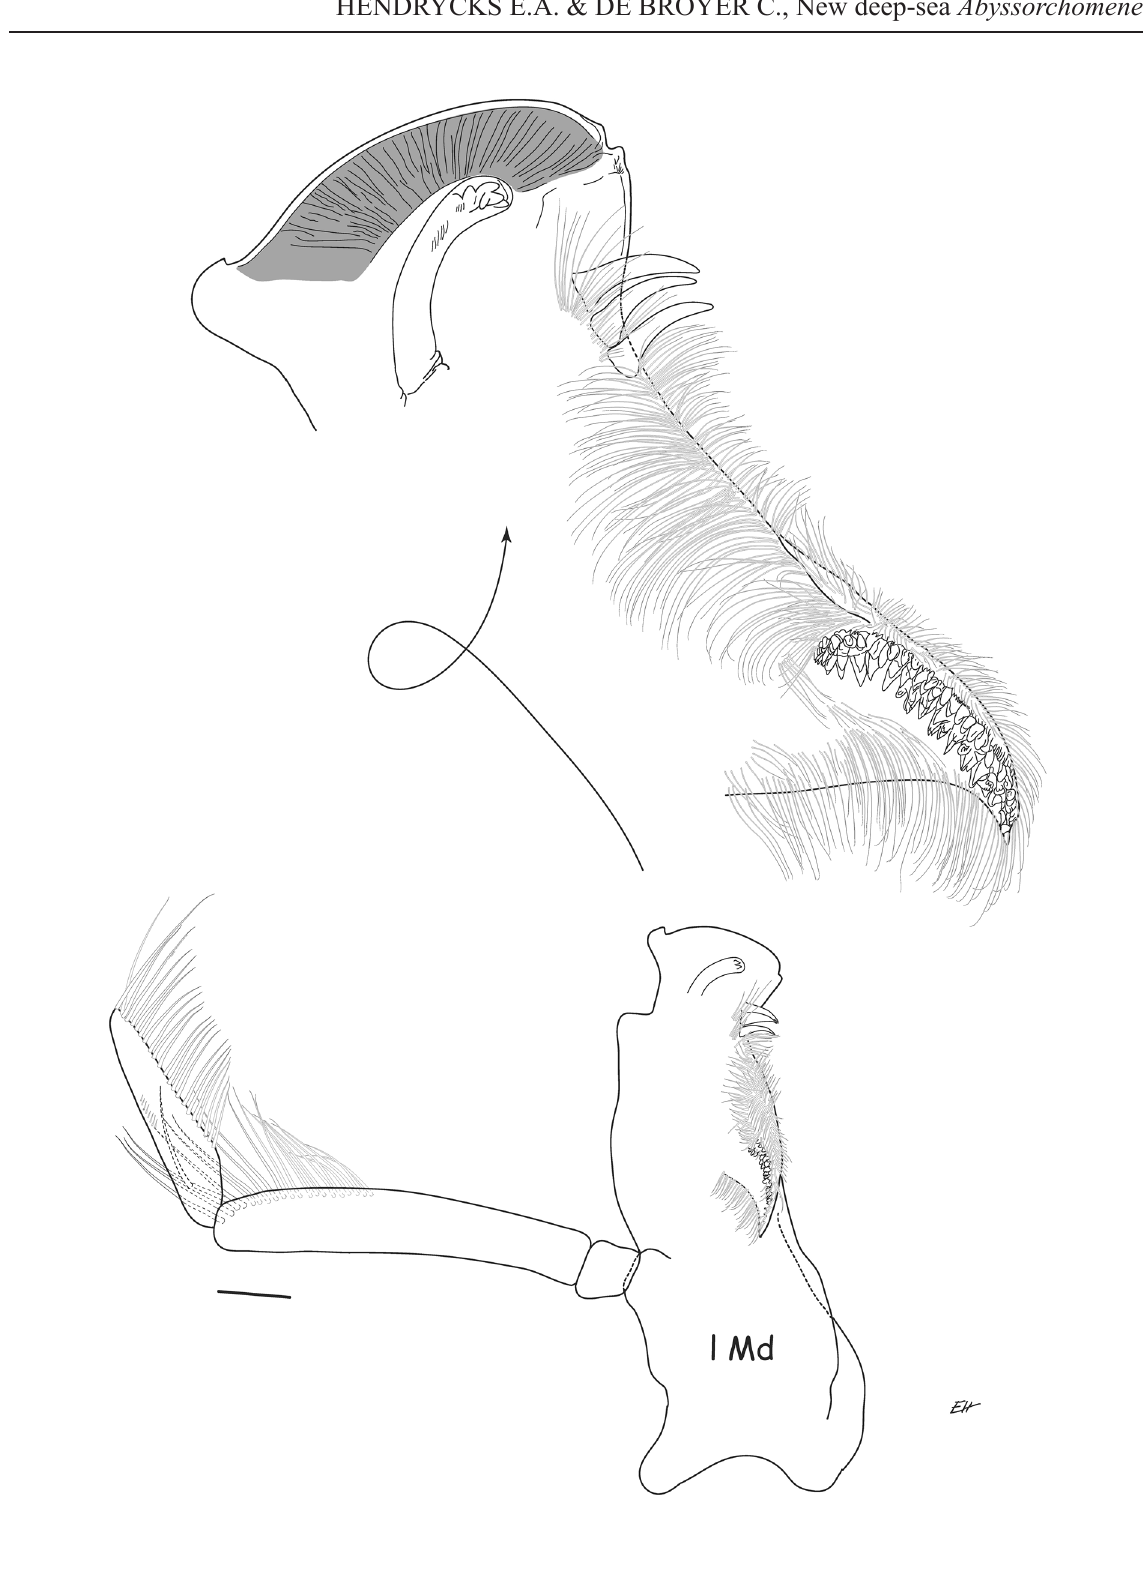
Fig. 6. Abyssorchomene abyssorum (Stebbing, 1888), holotype, ♂, 7.5 mm (BMNH 1889.5.15.23). Scale bar = 0.1